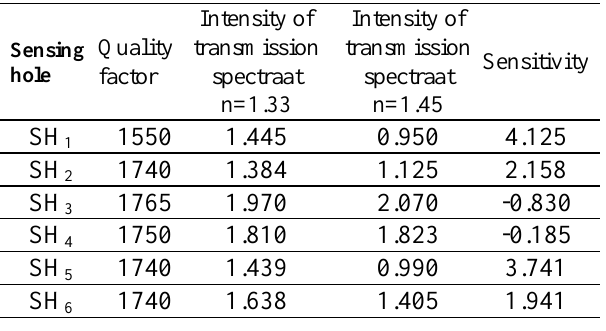
Table.1. The list of quality factor, intensity of transmission spectra, and sensitivity for different sensing holes.